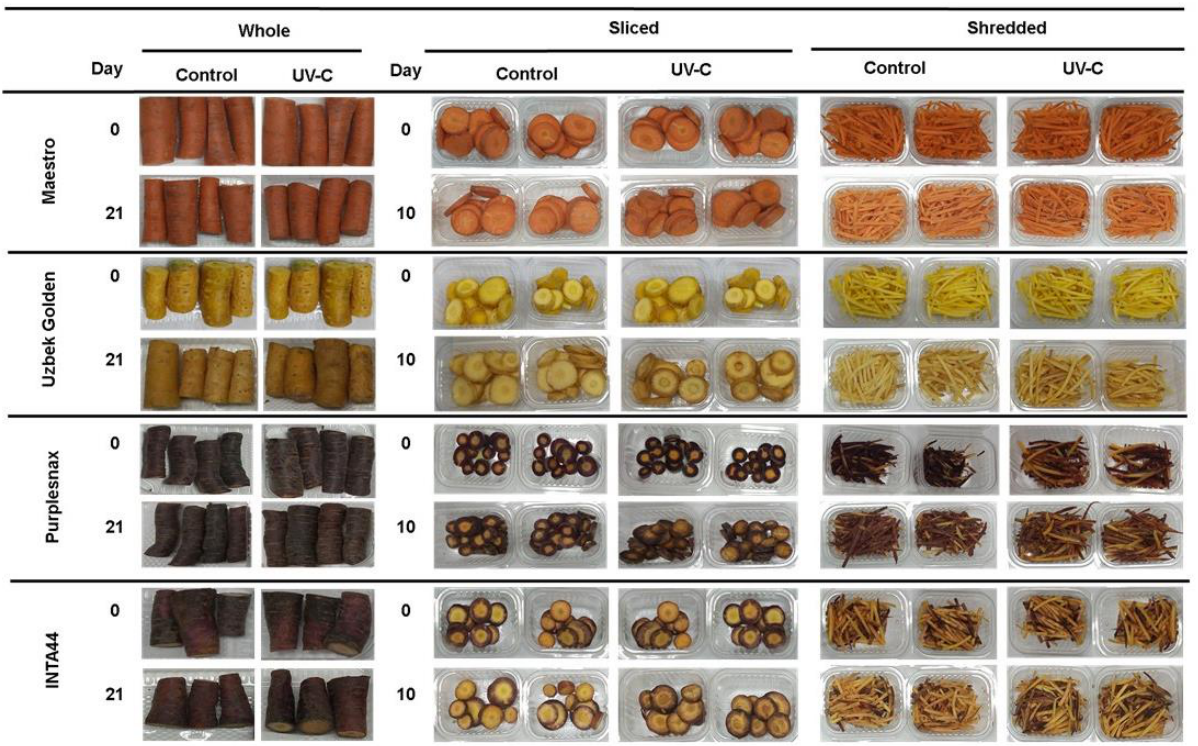
(cid:113) (cid:0) (cid:1) 2 + (cid:0) b ∗ (cid:1) 2 , where ∆ E is the color difference between (cid:1) 2 + (cid:0) a ∗ − L ∗ − a ∗ − b ∗ L ∗ 2 2 2 1 1 1